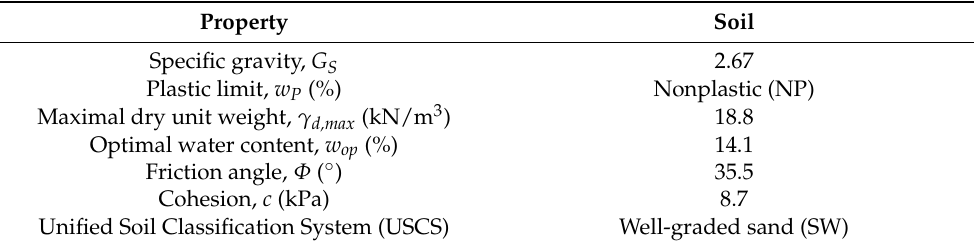
Table 1. Soil Table 1. Soil characteristics.